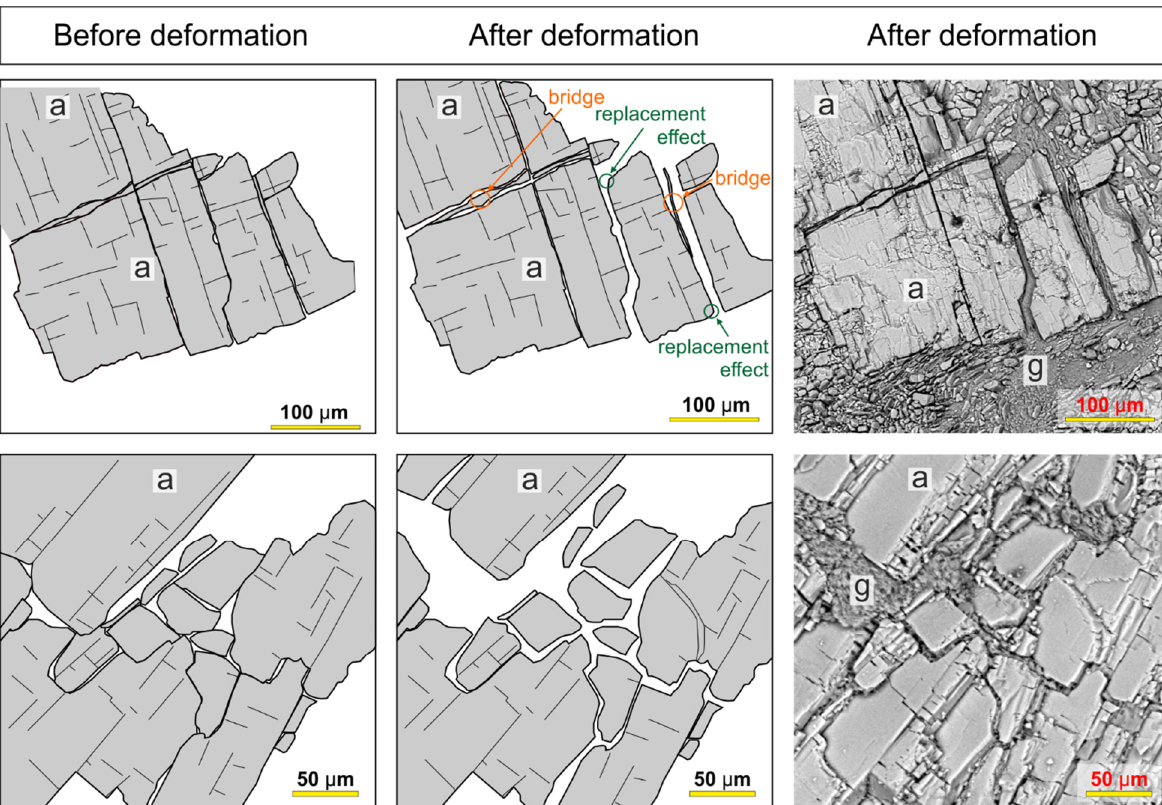
Figure 7. Restoration of the course of displacive and replacive growth of gypsum in two exemplary samples of the weathering anhydrite from Dingwall; BSE images of cut and etched surfaces are shown at right; a—anhydrite, g—gypsum. Note intra-grain mesh fabric on the upper pictures and inter-grain mesh fabric on the lower pictures. Further explanations in the text.